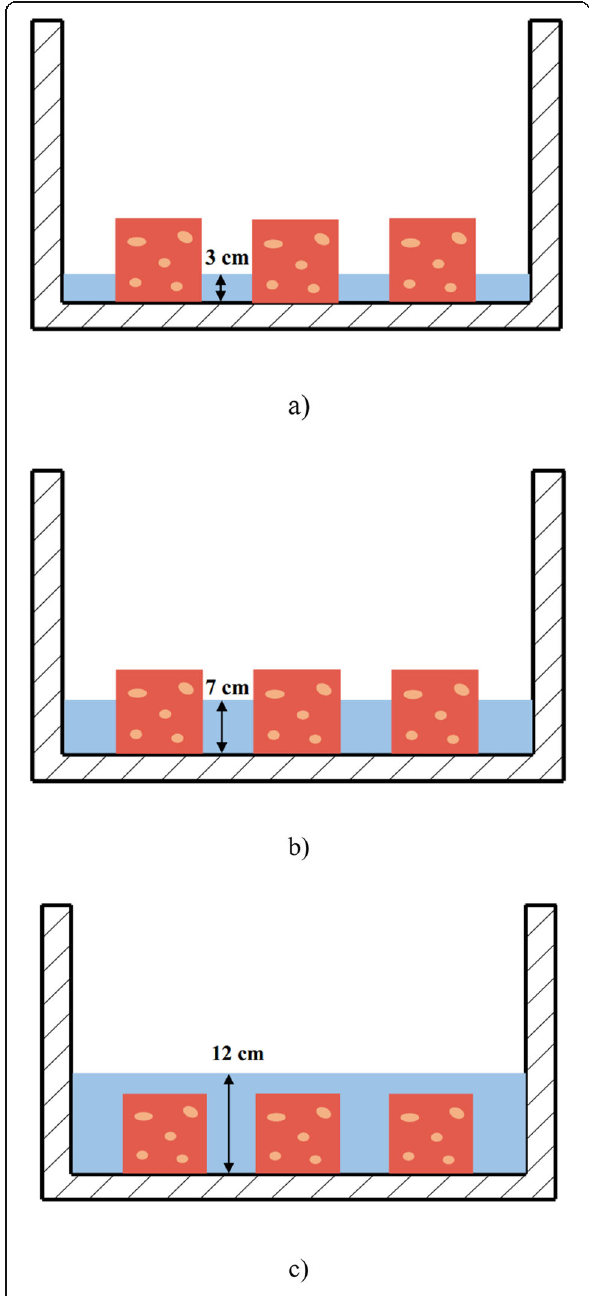
Fig. 2 The protocol of water absorption test: a) the water volume for the first 24 h; b) the water volume for the second 24 h; c) the water volume for the third 24